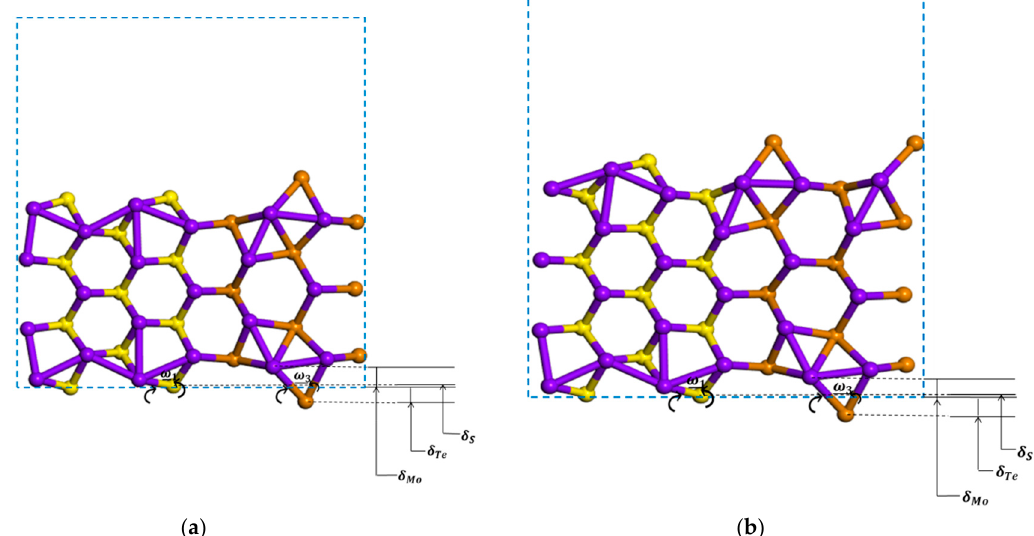
Figure 9. The relaxed geometries of 7-ac-(MoS 2 ) 3 /(MoTe 2 ) 3 -NR-sym ( a ) and 8-ac-(MoS 2 ) 3 /(MoTe 2 ) 3 -NR-asym ( b ). δ Mo , δ S , δ Te are the vertical displacements of the edge-layer Mo, S, Te atoms relative to unrelaxed structures, respectively. ω 1 and ω 3 are the tilt angles for the Mo-S and Mo-Te bonds from the horizontal line.